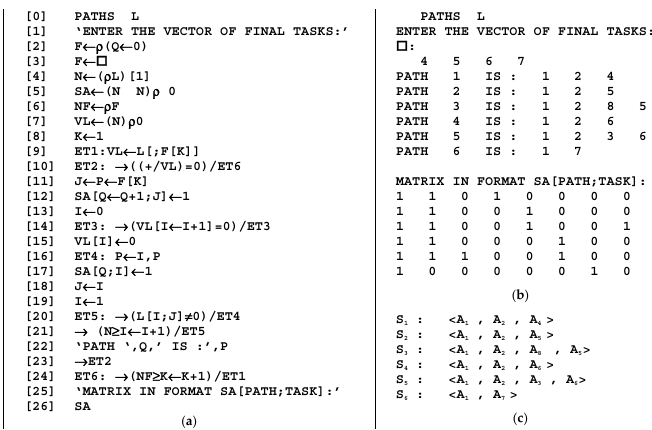
Figure 7. Program function PATHS—( a ) program code; ( b ) execution; ( c ) defined paths.